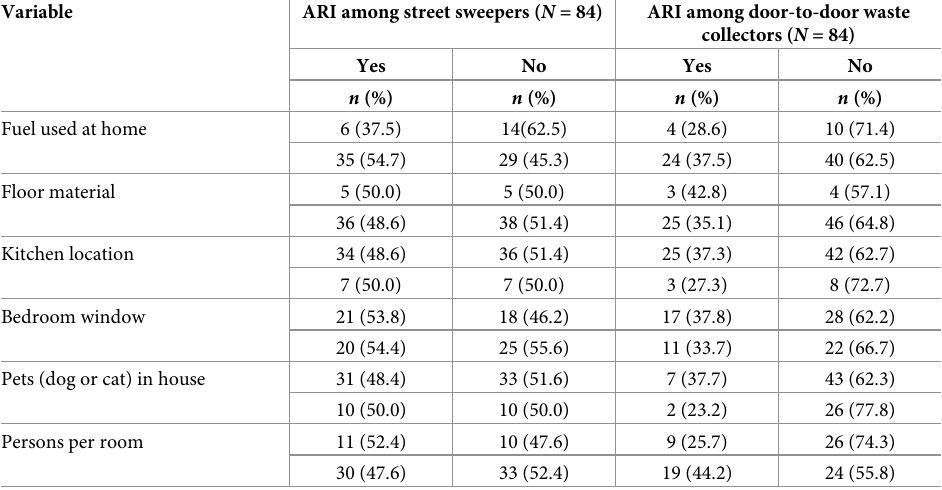
Table 3. Housing conditions among street sweepers and door-to-door waste collectors in Dessie City, Ethiopia March to May 2018. Variable ARI among street sweepers ( N = 84)